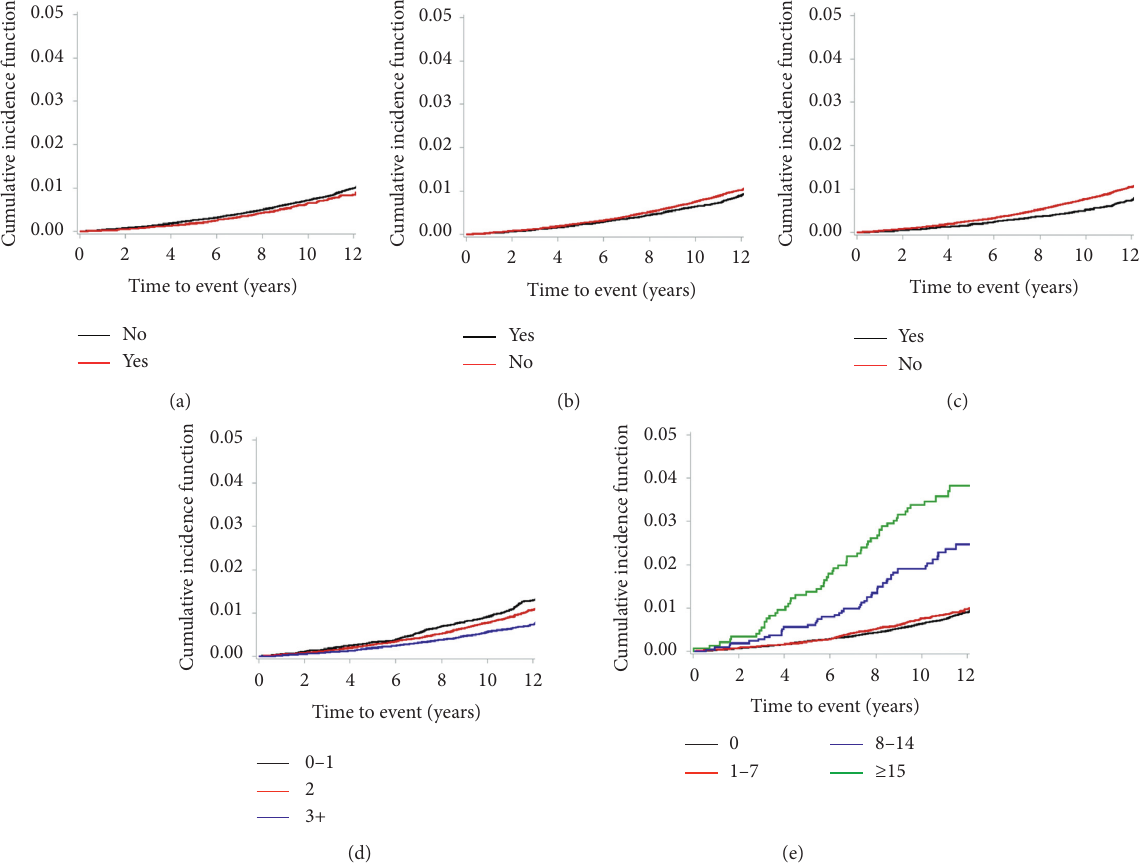
Figure 2: Cumulative incidence curves representing new-onset Parkinson’s disease. The cumulative incidence curves for new-onset Parkinson’s disease are presented with regard to the following: (a) presence of periodontal disease, (b) dental clinic visits for any causes, (c) competent dental care, (d) frequency of tooth brushings, and (e) number of tooth